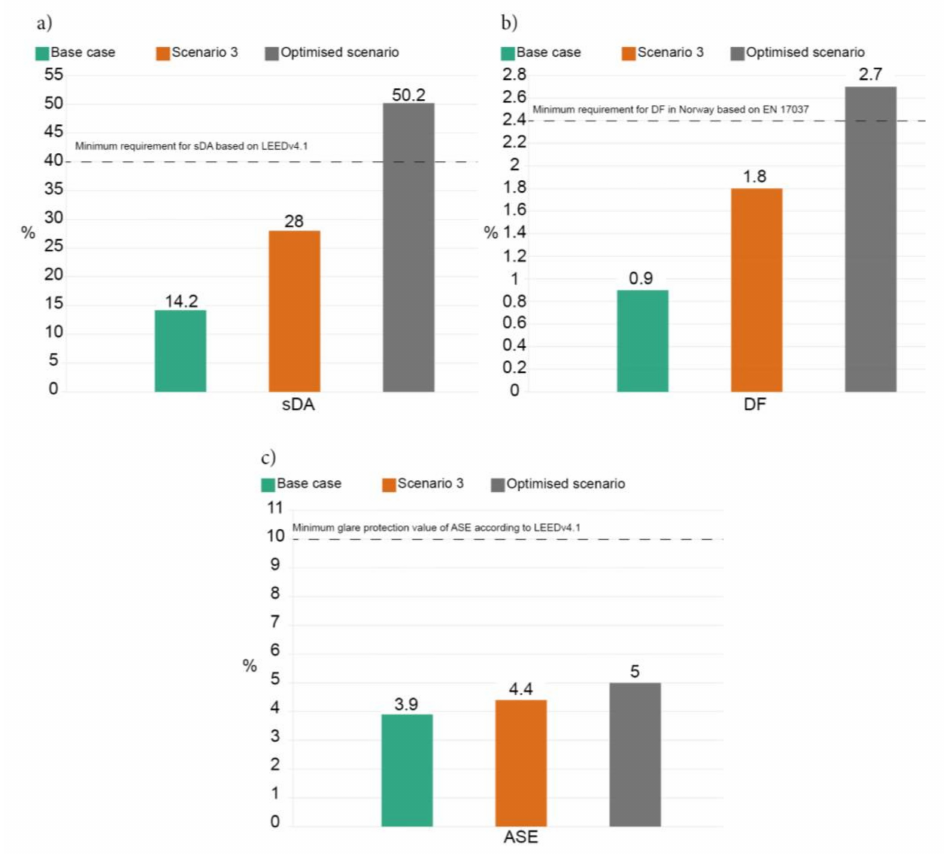
Figure 12. Results of simulated sDA 300,50% , ASE 1000,250 , and DF for Scenario 3 and optimized Scenario: ( a ) sDA 300,50% ; ( b ) DF; ( c ) ASE 1000,250